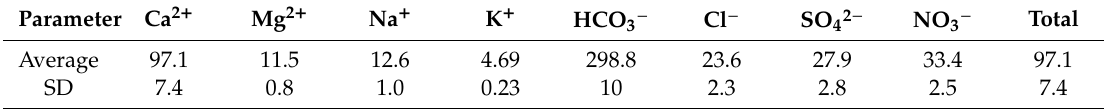
Table 3. Main characteristics of the major ions analyzed during baselining (mg · L − 1 ).